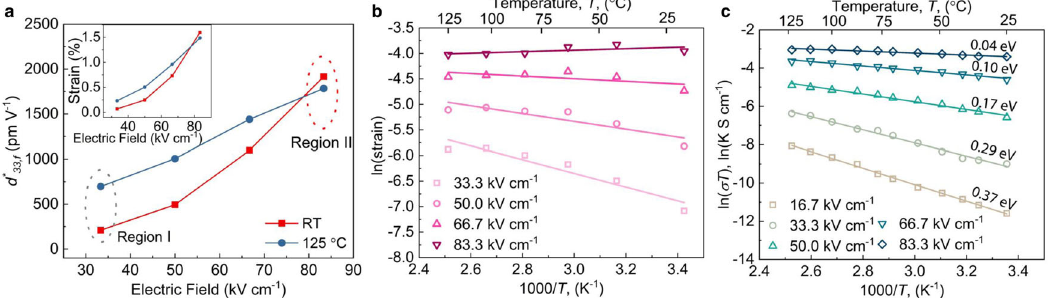
Fig. 4 Electrical characterization of defects in PF-KNN thin fi lm. a Variation in d * 33,f (and strain in the inset) measured at room temperature and 125 ˚ C. b Variation in the fi lm strain with temperature under different external electric fi elds presented in Arrhenius formalism. c Variation in the dc conductivity of PF-KNN fi lm with the temperature under different external electric fi elds presented as Arrhenius plot. All the piezoelectric measurements were done at 1